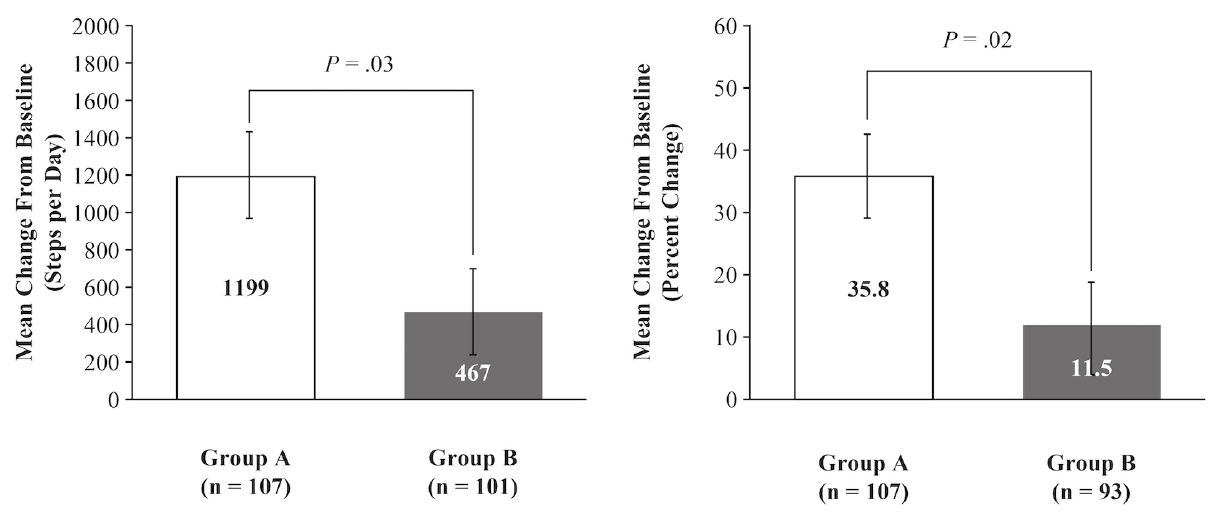
Figure 3. Steps per day. Mean change from baseline at day 90 in number and mean percentage change from baseline. Data are presented as least squares means and standard error. P values obtained from rank analysis of